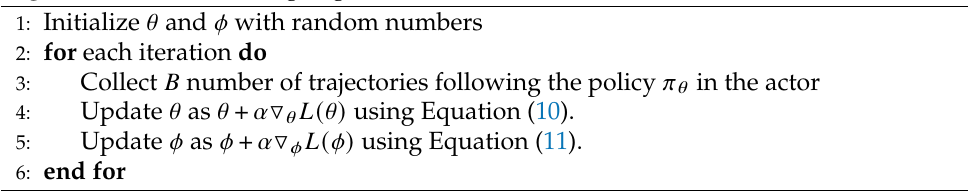
Algorithm 1 PPO Learning